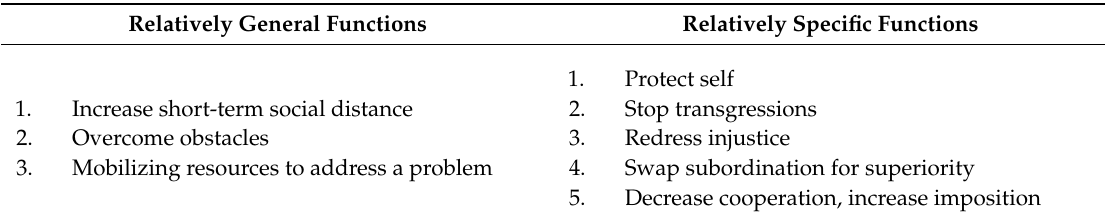
Table 1. Functions of